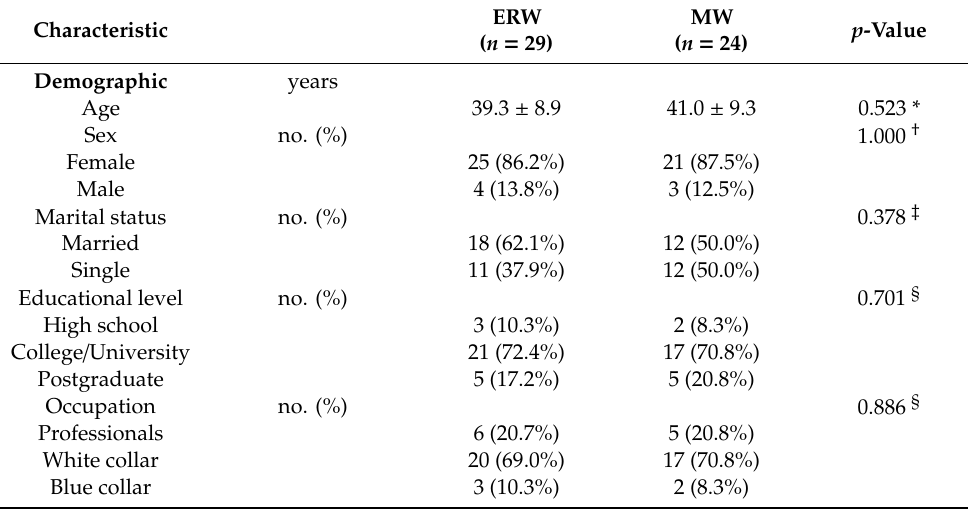
Table 1. Baseline characteristics of study